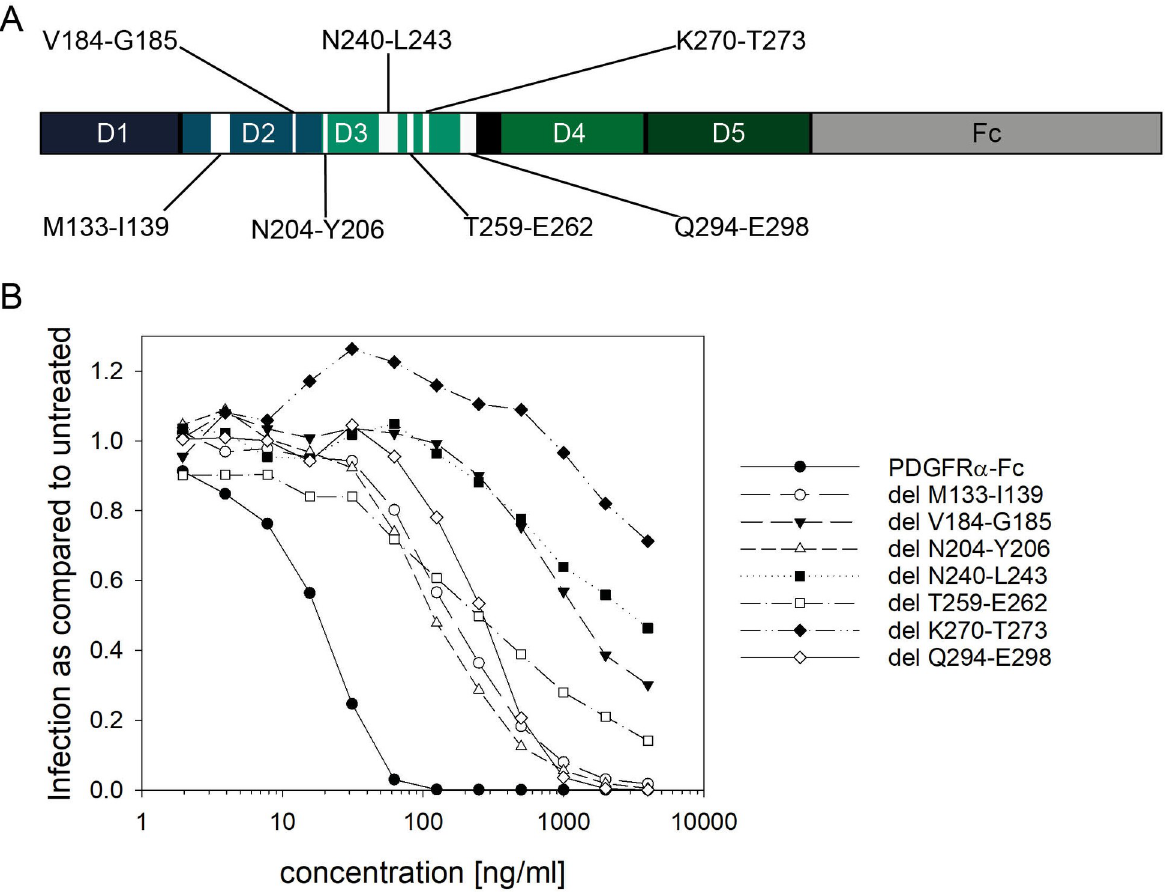
Fig 2. Screening of deletions in the predicted ligand binding sites of PDGFR α -Fc for their ability to inhibit HCMV infection. A : Overview of the relative locations of the predicted ligand binding sites in domains 2 and 3 of PDGFR α -Fc. Position numbers are based on the amino acid sequence of cellular PDGFR α (XP_005265800). B : The effect of PDGFR α -Fc wild type and deletion mutants on HCMV infection of fibroblasts was tested. Different concentrations of the soluble receptor variants were preincubated with an MOI of 1 of HCMV TB40-BAC4-IE-GLuc reporter virus. Expression of GLuc in samples treated with the different PDGFR α -Fc variants were compared to cells incubated with untreated virus. Dose response curves were generated as an average of 3 independent experiments using 2 different preparations of the luciferase expressing TB40-BAC4-IE-GLuc reporter virus and 2 different protein preparations of the soluble receptors.